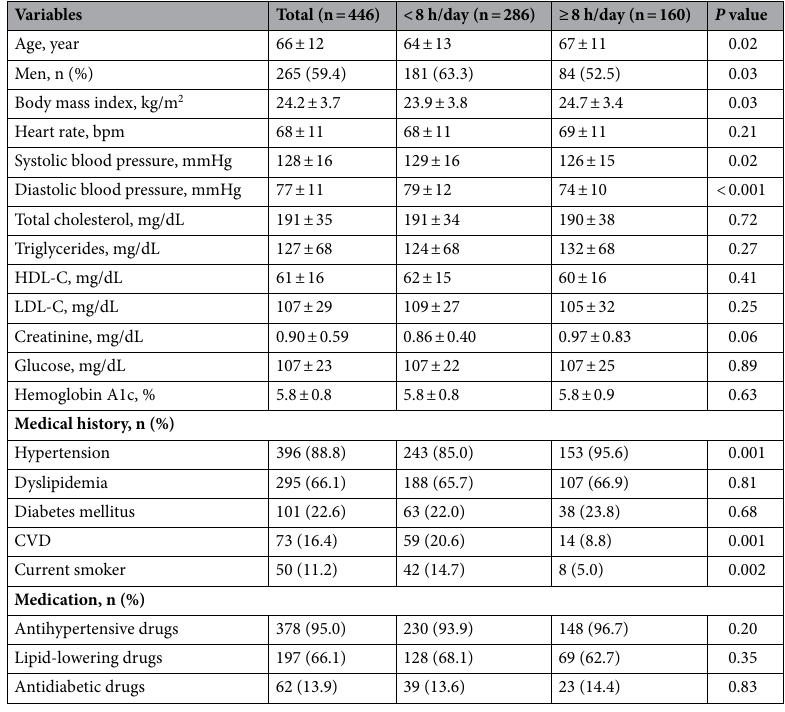
Table 3. Clinical characteristics of subjects with sitting time on a non-working day of < 8 h/day and subjects with sitting time on a non-working day of ≥ 8 h/day. HDL-C indicates high-density lipoprotein cholesterol; LDL-C, low-density lipoprotein cholesterol; CVD, cardiovascular disease.